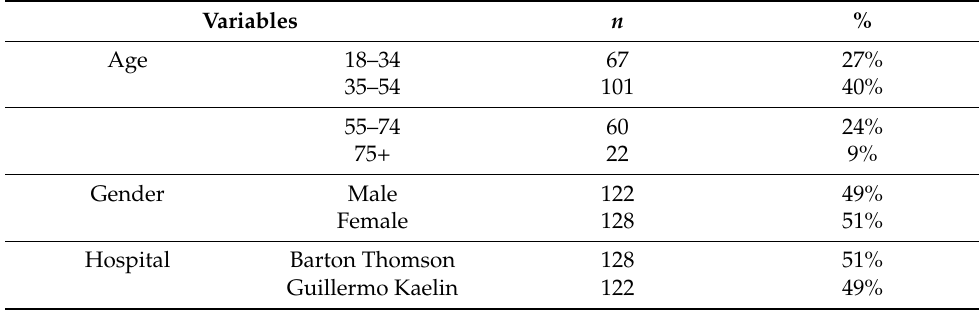
Table 3. Descriptive analysis regarding demographic characteristics of the